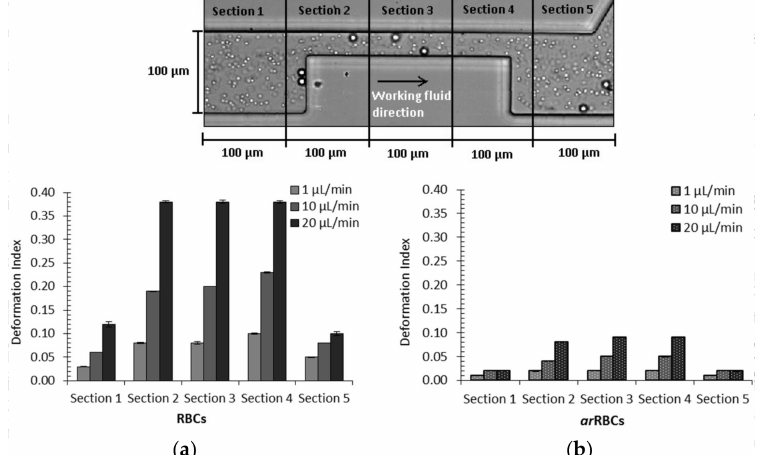
Figure 8. DI measured at five different sections of the stenosed microchannel for different flow rates: ( a ) healthy ovine RBCs; and ( b ) particles mimicking rigid RBCs (arRBCs). Error bars represent a 95% confidence interval (adapted from